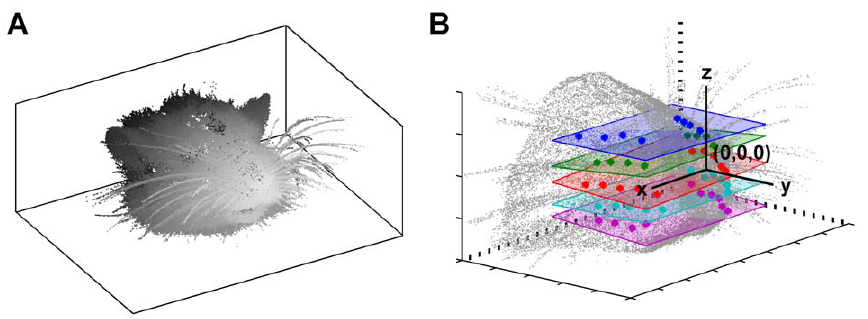
Figure 1. 3D head reference frame. ( A ) Representative point cloud obtained from the 3D scanner. ( B ) Standard position and orientation for the head. The rat’s snout is placed at the origin, and the rostrocaudal midline is collinear with the y-axis. Base points of whiskers in each row are aligned in planes (colored by row) that lie parallel to the xy -plane on average.